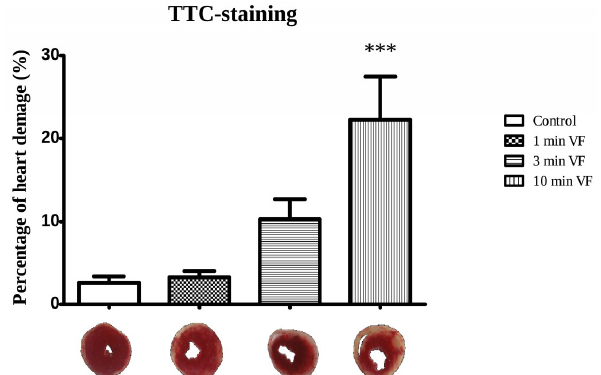
Figure 2. Effects of electrically induced ventricular fibrillation on infarcted size. The time-dependent effects of electrically induced VF duration (1, 3, and 10 min) followed by 120 min of perfusion on infarcted zone extent in isolated working hearts are shown. Hearts taken from ketamine/xylazine-anesthetized Sprague-Dawley rats and segregated into test groups of 6 hearts per group, were subjected to 0, (Control), 1, 3, and 10 min periods of electrically-induced VF (20 Hz, 1200 beats/min), respectively, followed by 120 min of perfusion. Staining, to demonstrate infarcted areas of heart tissue, was accomplished with triphenyl tetrazolium chloride (TTC) solution in phosphate buffer. The percentages of heart damage were assessed in 2–3 mm thick sections transversely sliced from the apico-basal axis into 2–3 mm thick sections and analyzed using ImageJ software. Infarcted areas were measured by computerized planimetry software and infarct magnitude was determined as percentage ratio of the infarcted zone to the total area in each heart (percentage of pixels). Results are shown as average values from each group of rat hearts ± SEM, and in comparison, with the control value. n = 6 in each group, *** p <